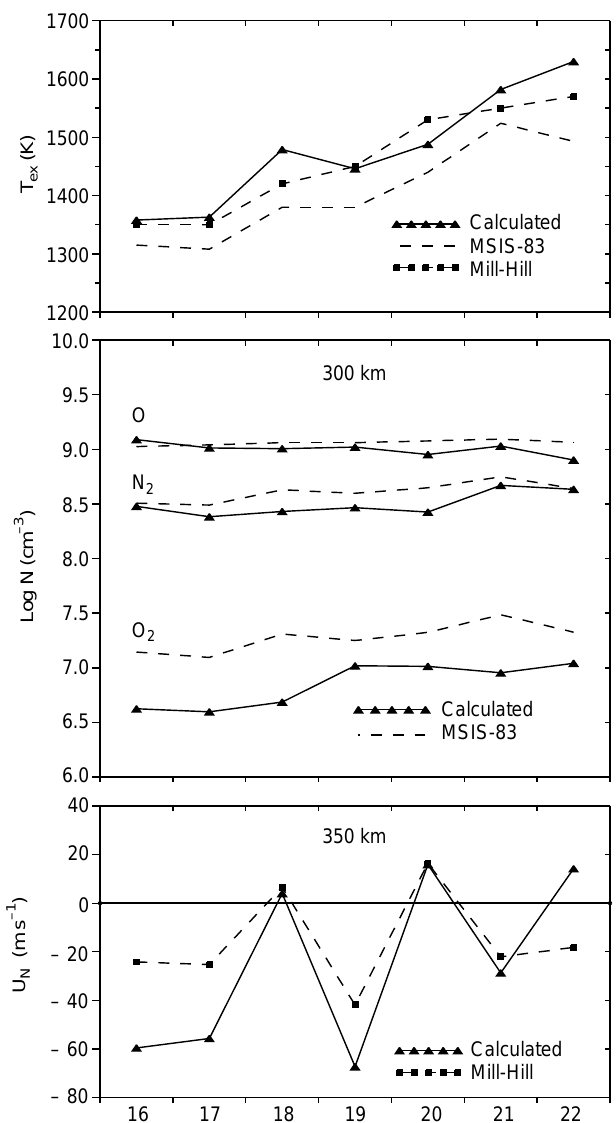
Fig. 5. Observed log N m F 2 and h m F 2 variations for the March 16–22, 1990 period, calculated log q( O (cid:135) )/ (cid:98) , O/ N 2 ratios and vertical plasma drift at the height of F2–layer maximum as well as O (cid:135) ion outflow at 600 km, compared to the Millstone Hill estimates (dashes) given along with standard deviations. MSIS–83 model O/ N 2 prediction is shown for comparison (dashes). Calculated W values are given in the lower box. Figures along the x axis (UT) are dates of March 1990